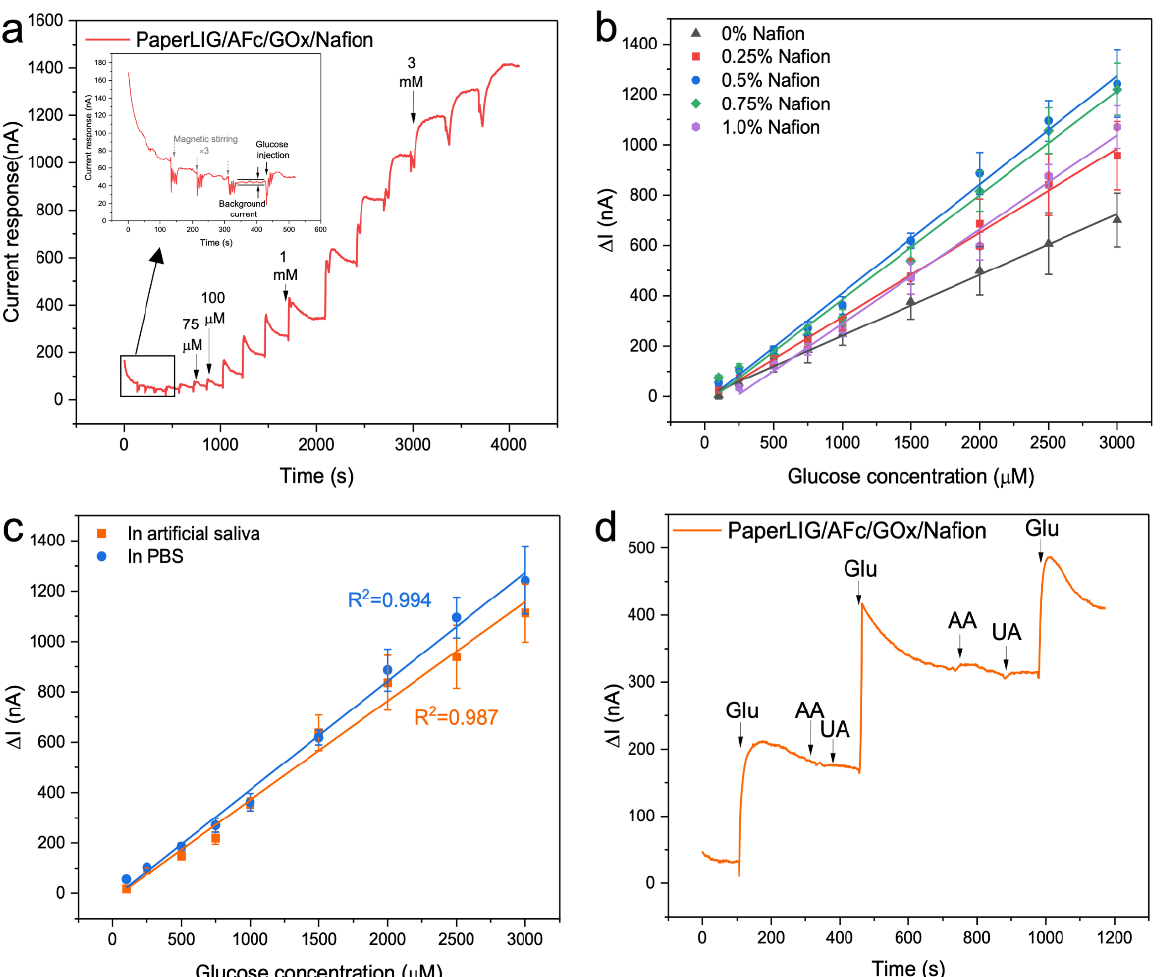
Figure 4. ( a ) Amperometric response of PaperLIG/AFc/GOx/Nafion electrode to different glucose concentrations in the PBS (applied potential for amperometry: − 90 mV, Nafion concentration 0.25%). The inset shows the enlarged response from the black square marked area. ( b ) The corresponding calibration curves for PaperLIG-based glucose biosensor in the PBS were prepared using different concentrations of Nafion ( n = 3). ( c ) The corresponding calibration curves for PaperLIG/AFc/GOx/Nafion (0.5%) glucose biosensor in artificial saliva (orange line) and the PBS (blue line) ( n = 3). ( d ) Interference test of the PaperLIG-based glucose biosensor: response to 500 µM glucose in the presence of common interfering substances in artificial saliva (20 µM AA and 200 µM UA).